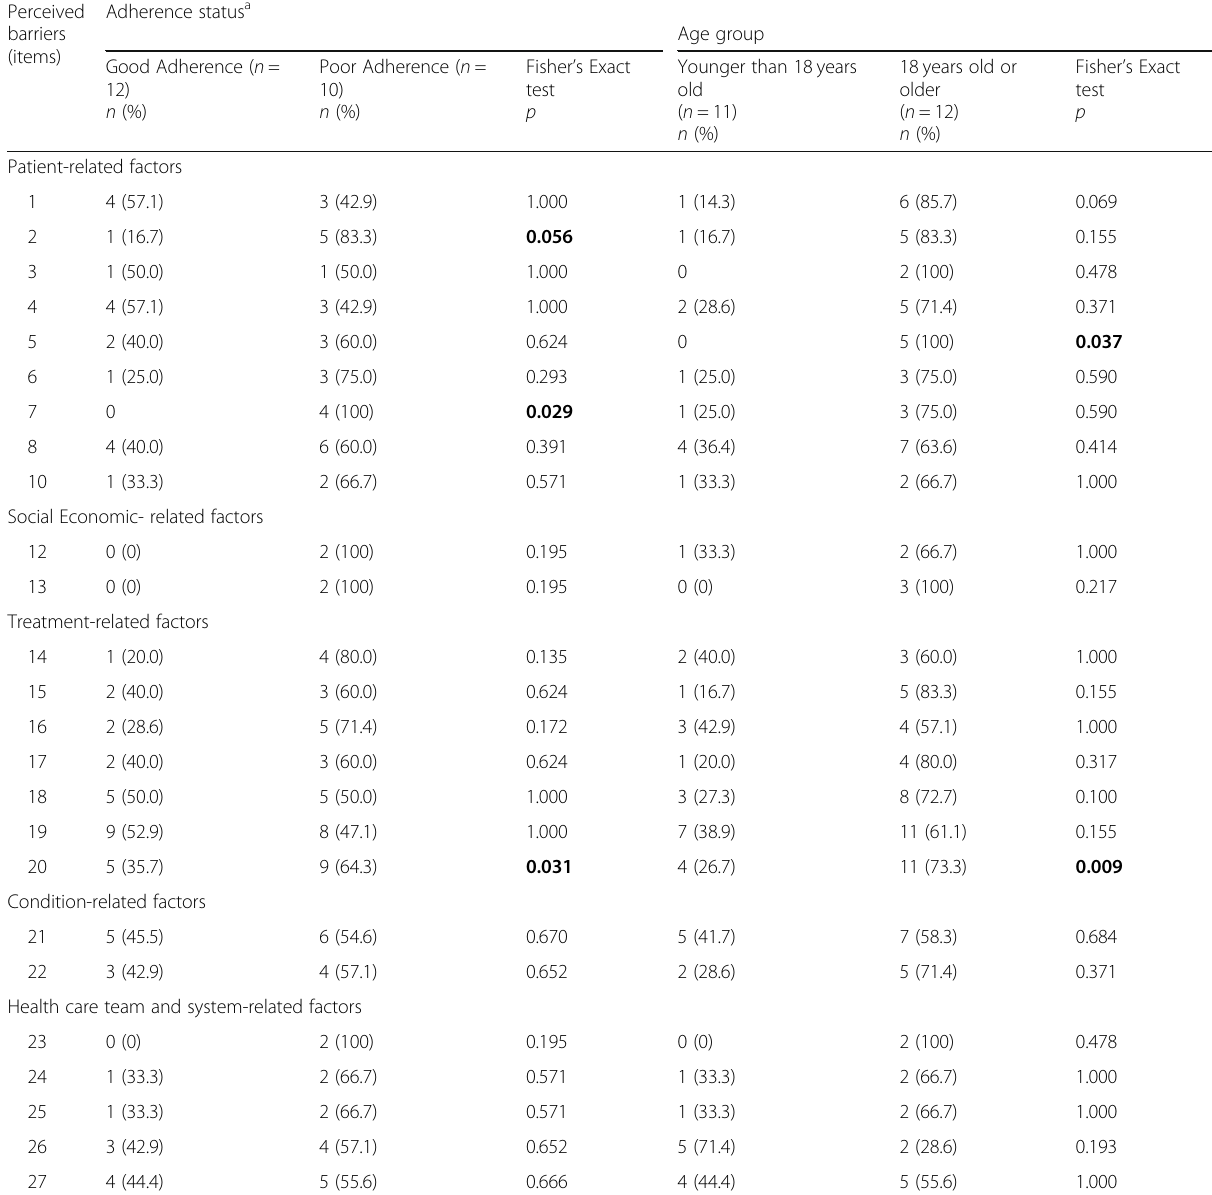
Table 6 Frequency of agreement in each item of Phenylketonuria Perceived Barrier to Treatment Inventory according to adherence and age